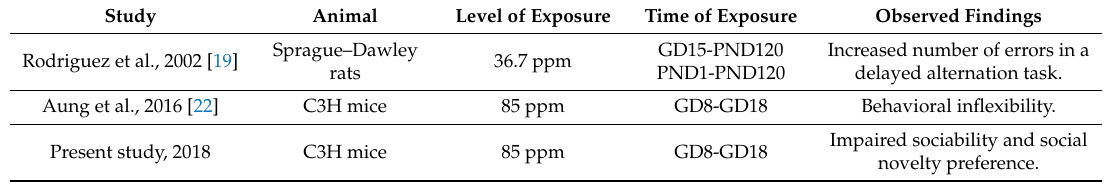
Table 1. Comparison of animal studies on the neurotoxic effects of developmental arsenic exposure.